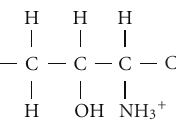
Figure 6: Zwitterionic state of